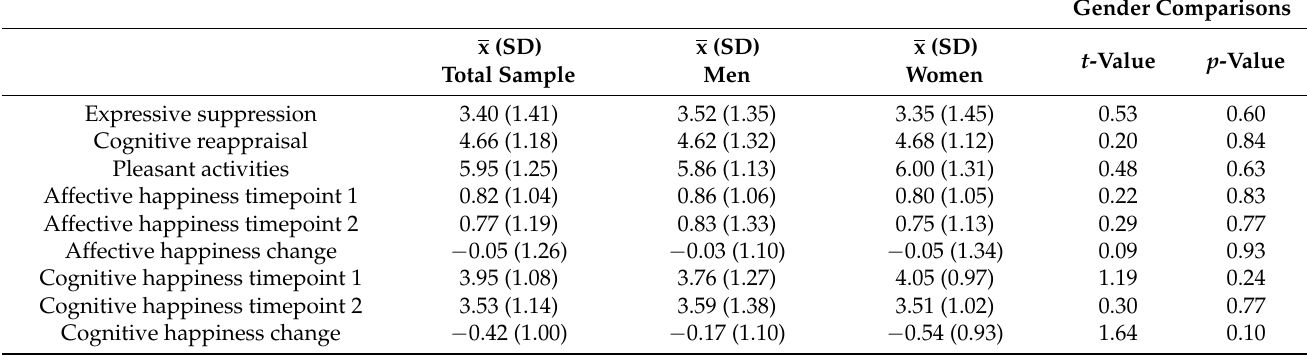
Table 1. Descriptive statistics (mean and standard deviation (SD)) of the total sample and separated by gender for the variables included in this